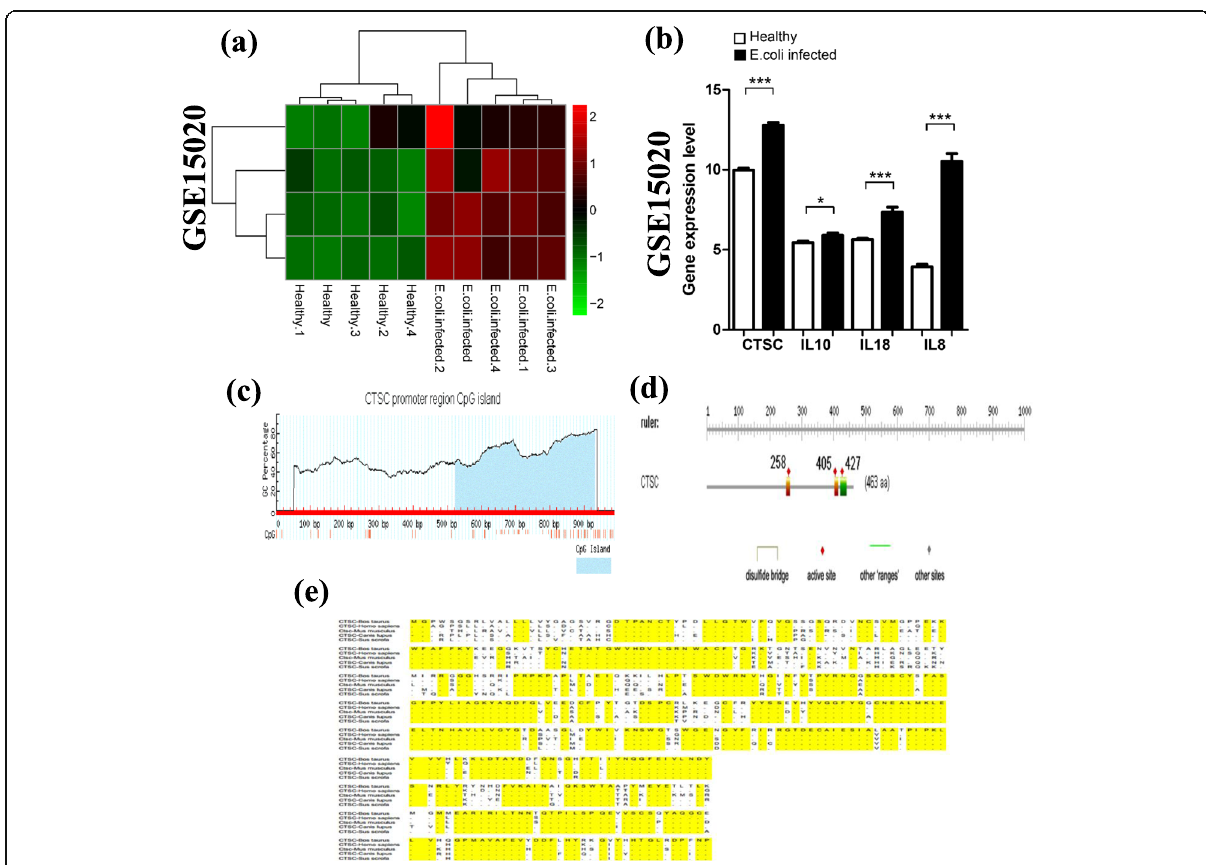
Fig. 4 a Heatmap of selected 4 DEGs. b Barplot of selected DEGs. * Refers to 0.01 ≤ p < 0.05, ** refers to 0.005 ≤ p < 0.01, *** refers to p < 0.005. c CpG island in the promoter region of CTST. The blue-filled region is CpG Island. d Presents the active sites in the differentially expressed gene (DEG) of CTSC. e Alignment of CTSC protein among 5 different species. The highlight sequence parts with yellow were consensus sequences of different species